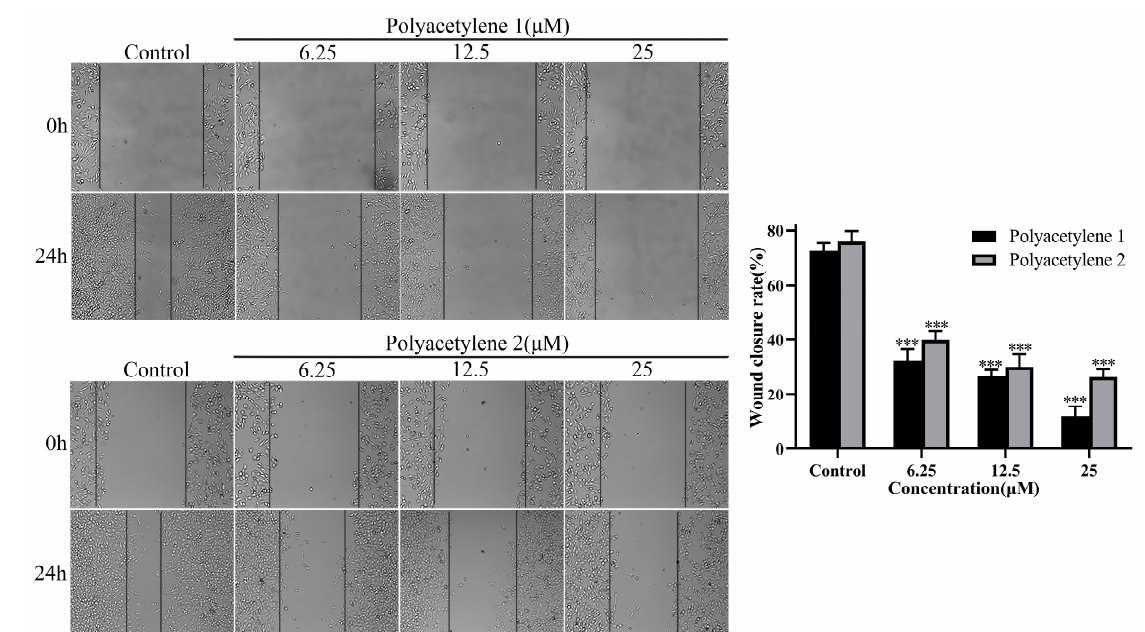
Figure 3. Effects of polyacetylenes 1 and 2 on the wound-healing capacity of HGC-27 cells. The HGC-27 cells were treated with 25, 12.5, and 6.25 µ M polyacetylene 1 or 2 for 24 h (magnification: 100 × ). Compared with the control group, polyacetylenes 1 and 2 inhibited the wound-healing ability of HGC-27 in a dose-dependent manner, in which the inhibition ability of polyacetylene 1 was more significant. Significant differences compared with the control group are designated as *** p < 0.001. Results are expressed as the mean ± SEM (n =